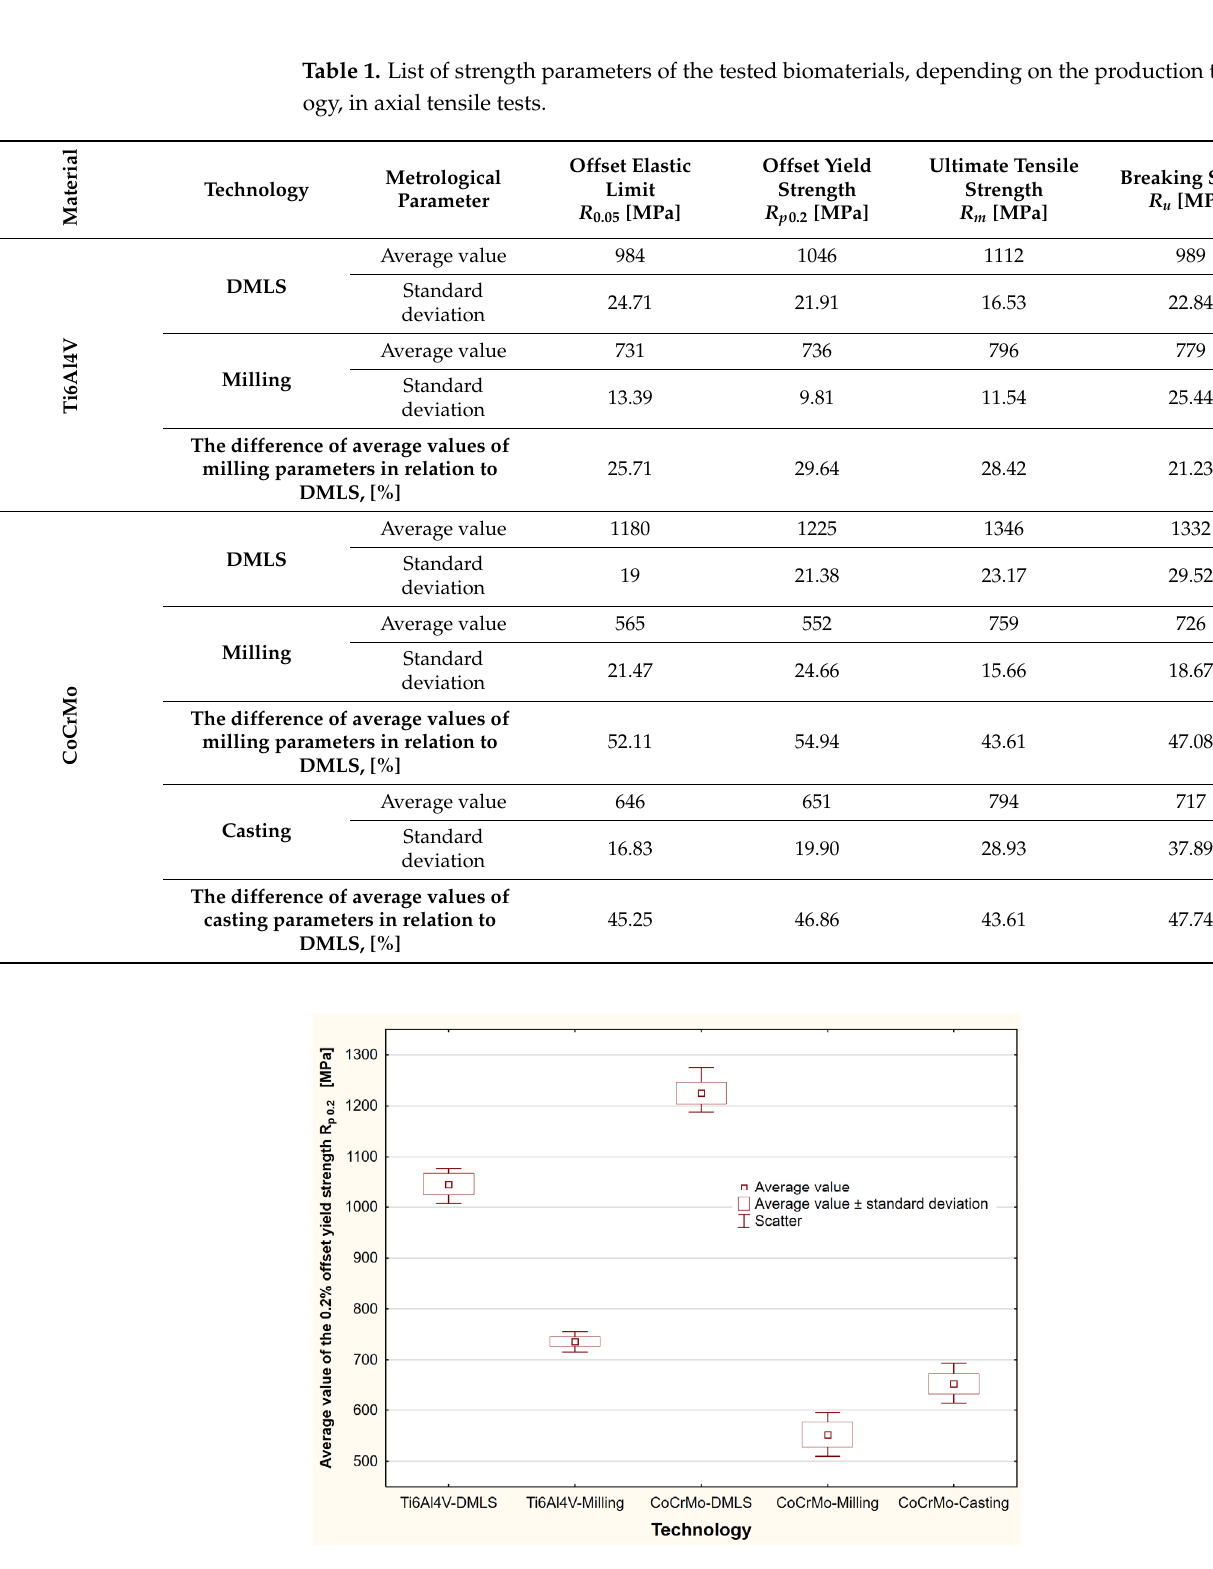
Figure 4. Statistical study to determine the offset yield strength under axial tension, depending on the manufacturing technology.